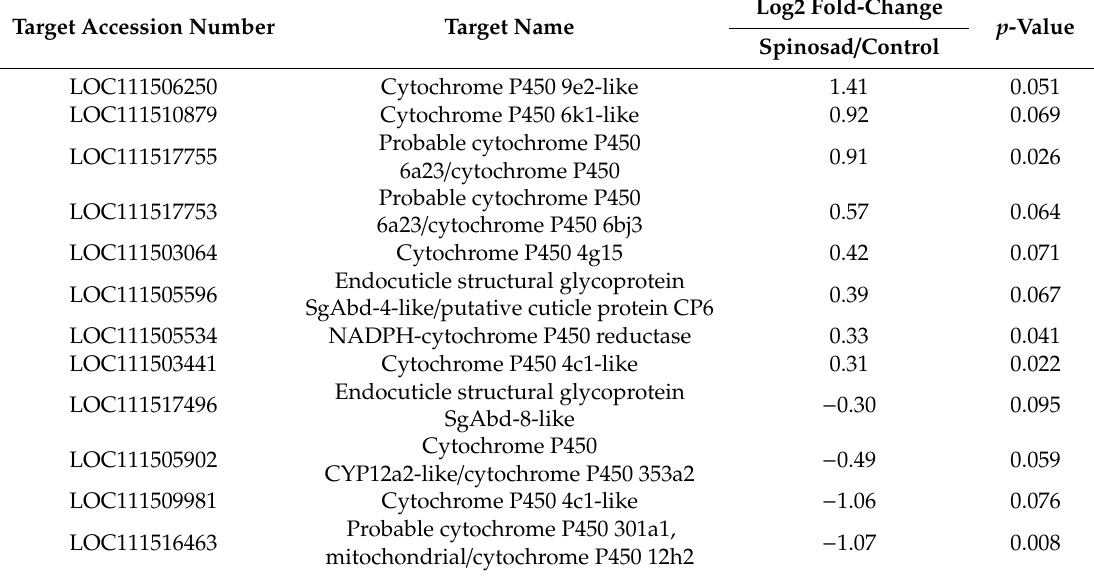
Table 3. Di ff erential expression of select transcripts with putative relevance to insecticide responses in L. decemlineata treated with spinosad as measured by high-throughput